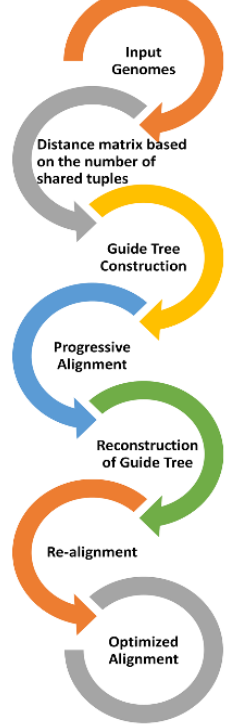
Figure 3. Multiple sequence alignment process by MAFFT v7.4.2. Multiple sequence alignment was carried out in a multistage process to generate the final accurate alignment. Subsequent phylogenetic analysis was conducted using MEGA-X. analysis was conducted using